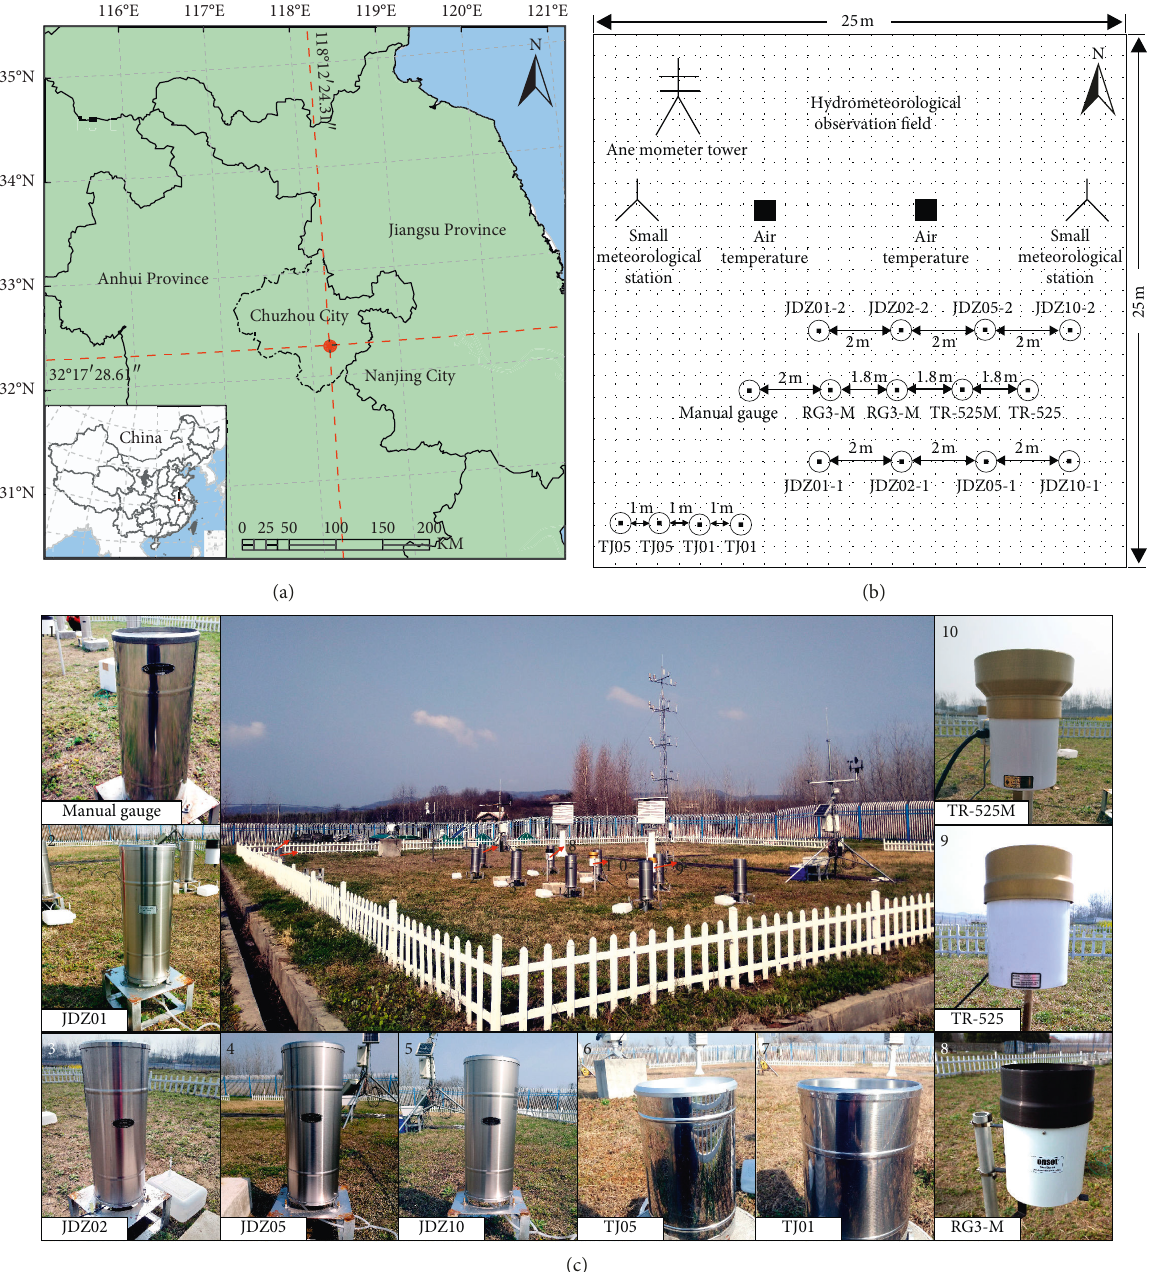
Figure 1: (a) Field view of the Chuzhou hydrological experiment station, (b) distribution of 10 models rain gauges, and (c) the site of hydrometeorological observation